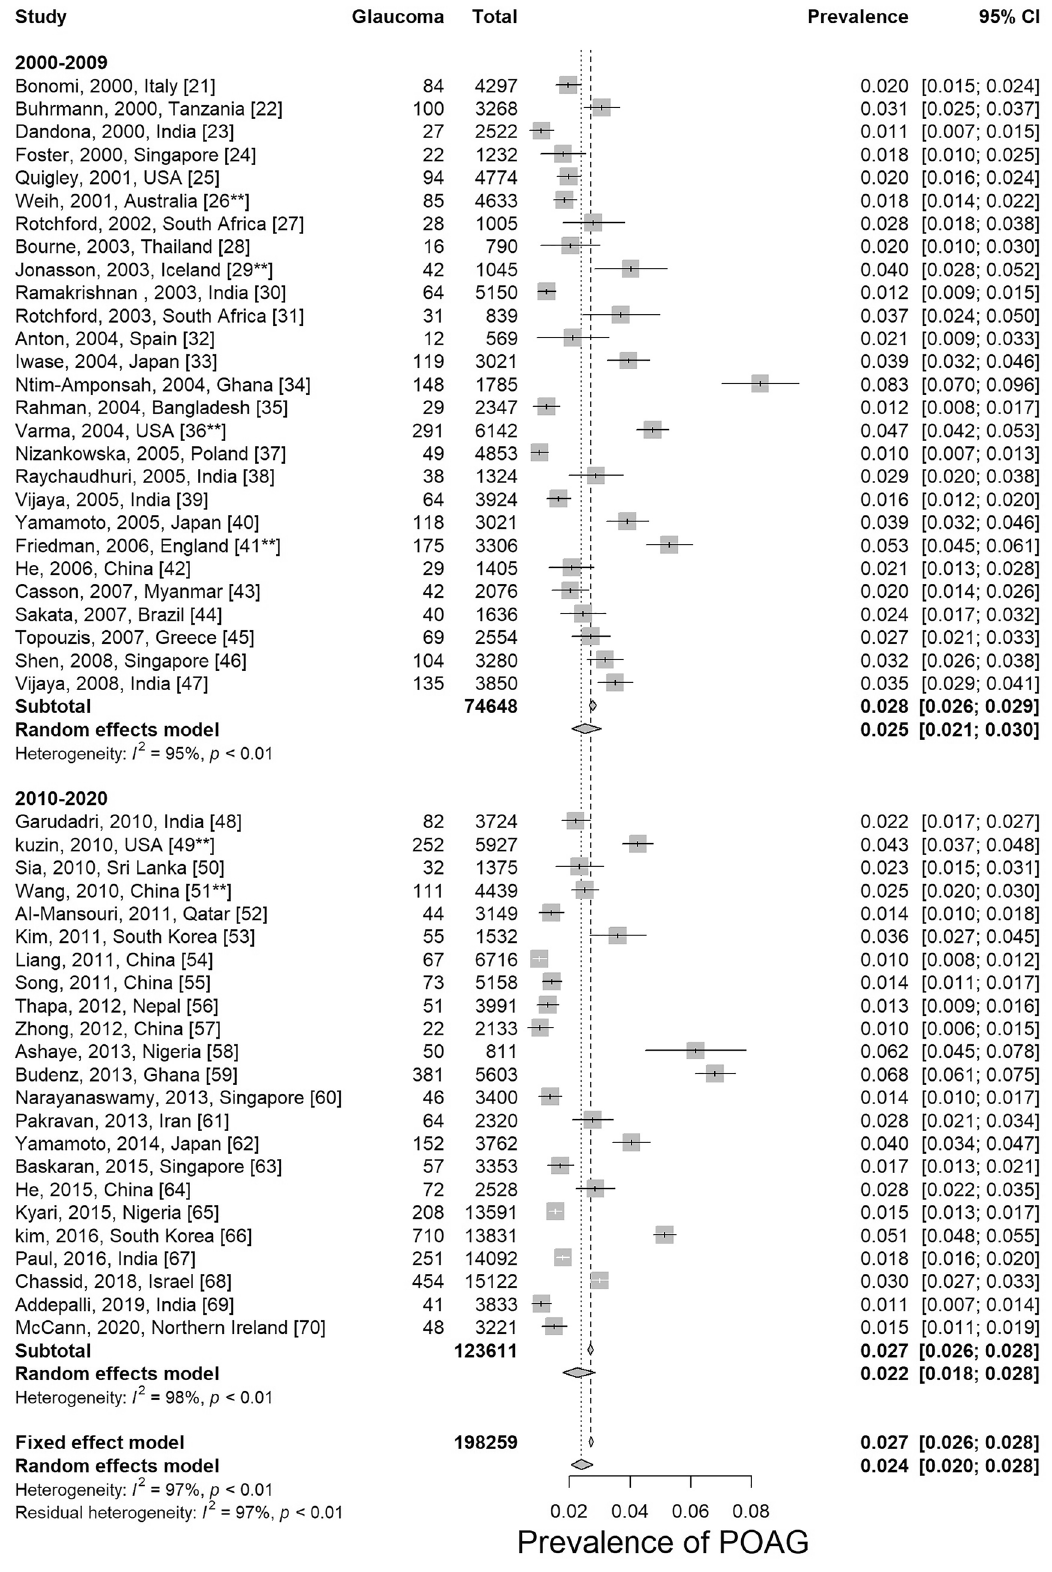
Figure 2. Prevalence of primary open-angle glaucoma by decades. POAG primary open-angle glaucoma. There is no statistical difference between the first decade (2000–2009) and the second decade (2010–2020) in the global prevalence of POAG (p = 0.472). **Studies that reported prevalence of open-angle glaucoma (OAG), but not